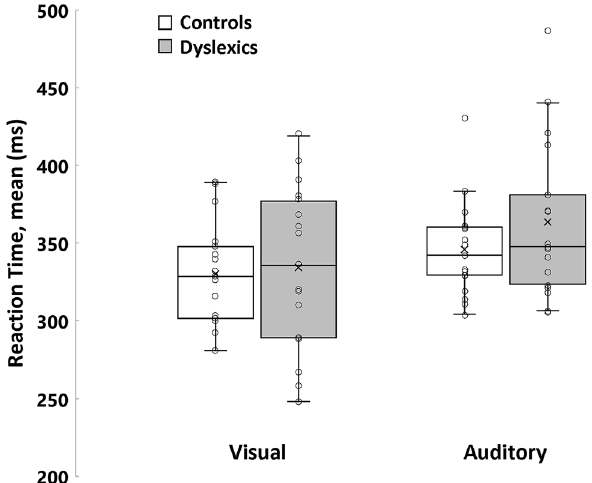
Figure 1. Mean Visual and Auditory Reaction Times. The box lines indicate the 25th, 50th, and 75th percentiles, and the whiskers extend to the 5th and 95th percentiles. Dots display individual values (n = 17 in each group), and the cross indicates the